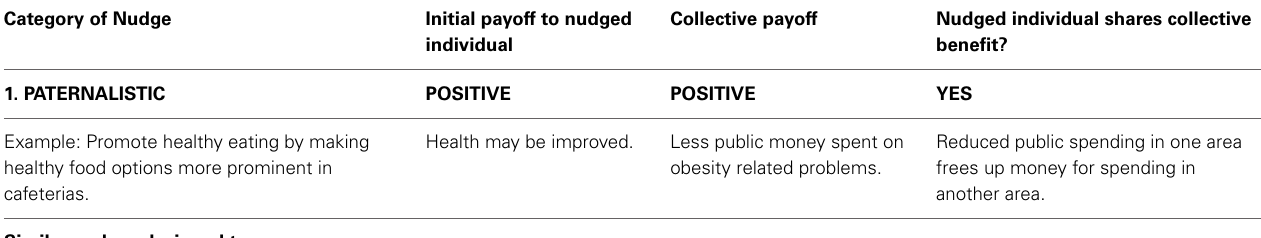
Table 1 | Ethical hierarchy for policymakers when designing and implementing nudges. Category of